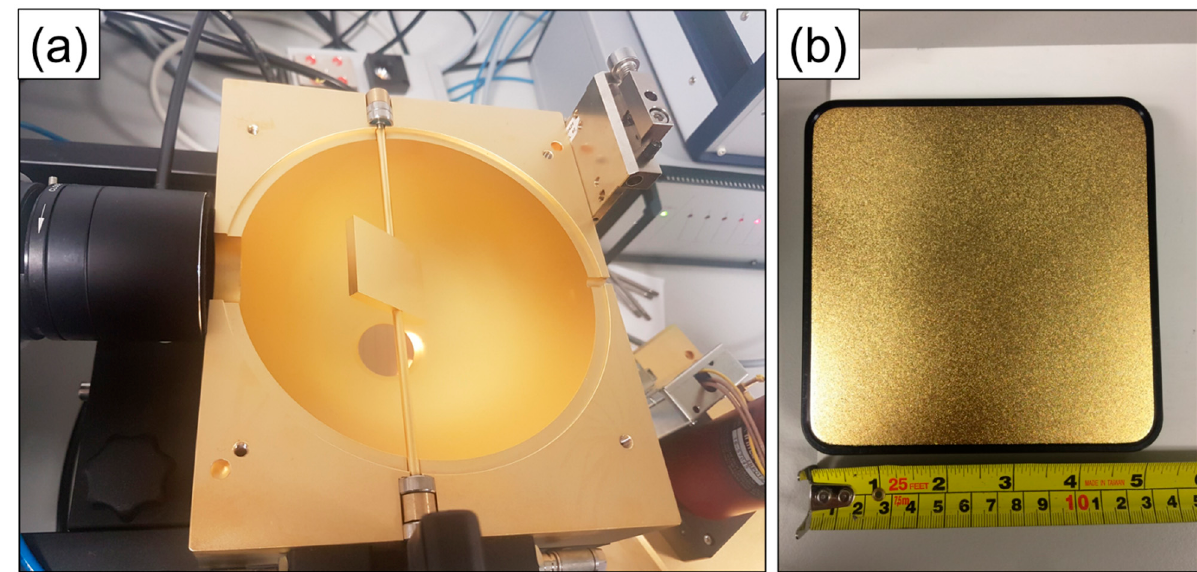
Figure A3. ( a ) The inside of the integrating sphere (image taken during installation) and ( b ) the diffuse Infragold target used as the reference target for the substitution method of calibration for the setup at King’s College London.